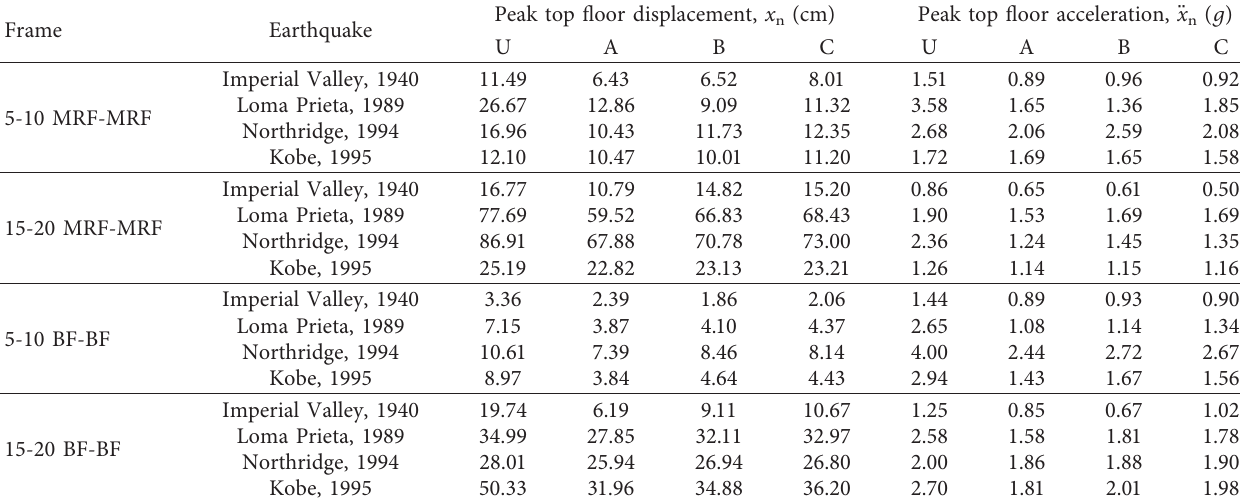
Table 10: Peak top floor displacement and acceleration responses of dissimilar connected buildings for unequal storey height under historical earthquake ground